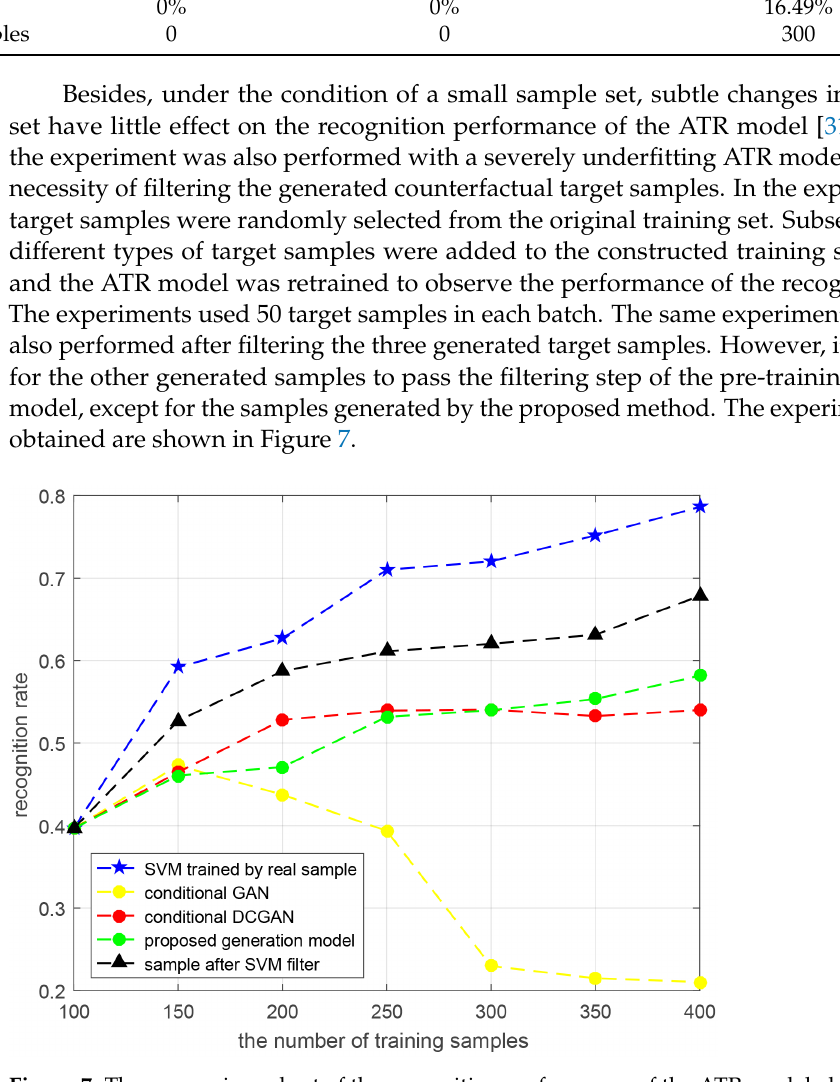
Figure 7. The comparison chart of the recognition performance of the ATR model obtained through different training sample sets. Only the target samples generated by the proposed generation model can be